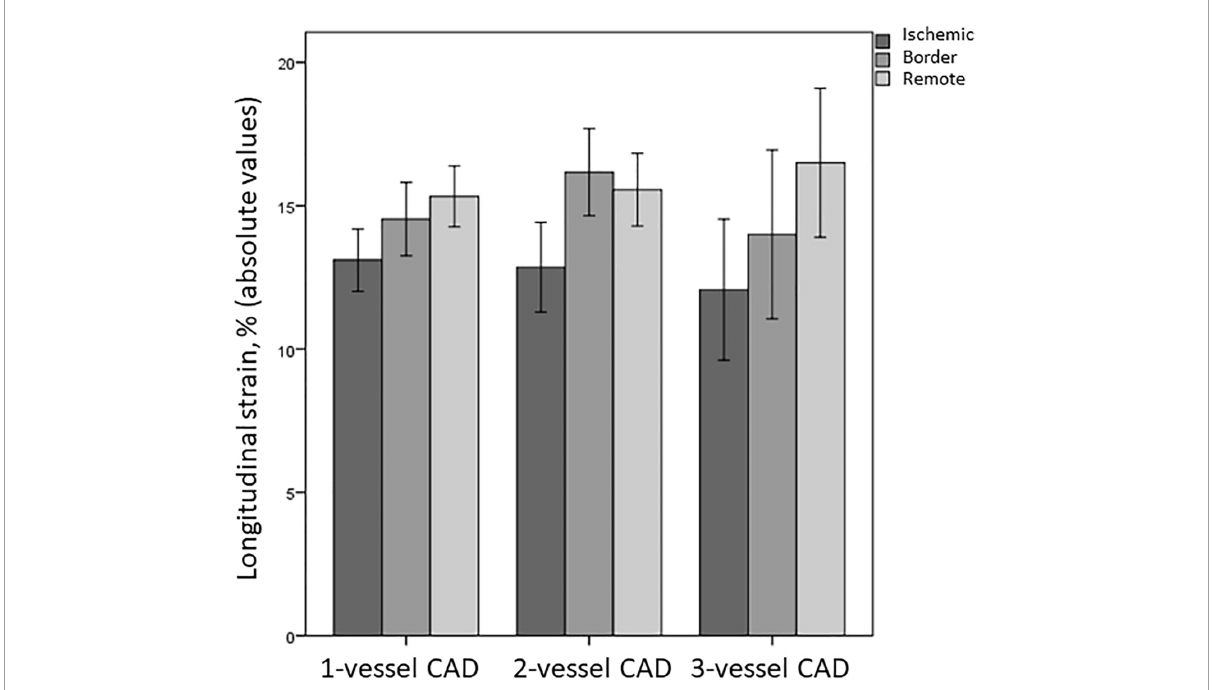
FIGURE2 Differences in LS of ischemic, border, and remote myocardium between patients with single-vessel, two-vessel, and three-vessel CAD. CAD, coronary artery disease.